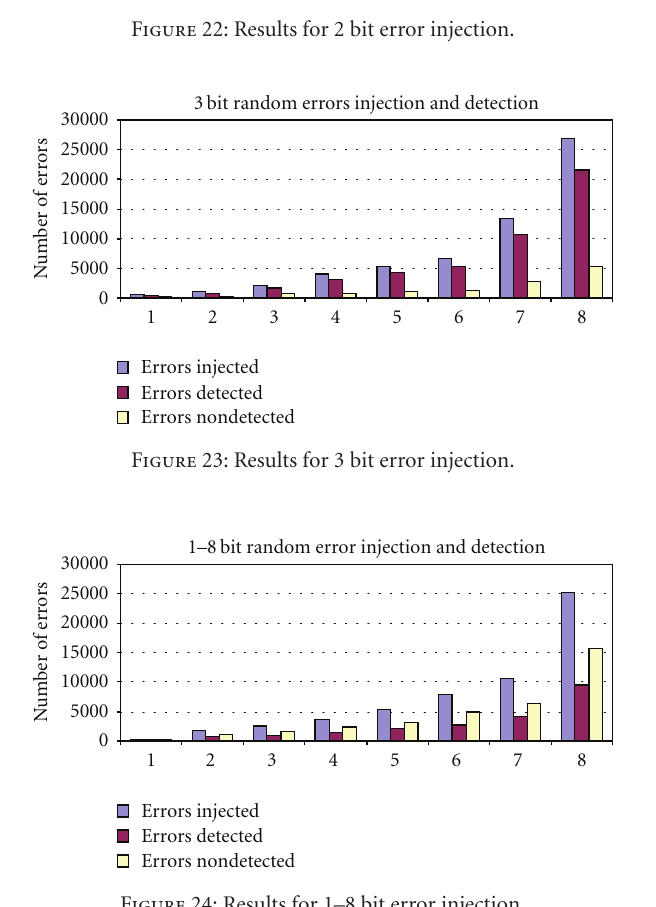
Figure 24: Results for 1–8 bit error injection.